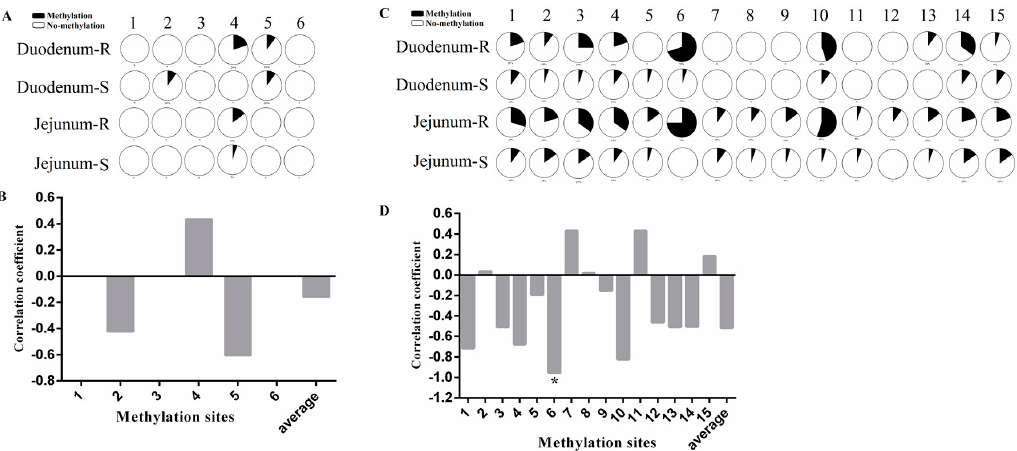
Figure 7. Methylation analysis of CpG islands in the TLR5 promoter region and correlation with mRNA expression. ( A , B ) represent methylation analysis for single site of CpG1 and its correlation analysis with mRNA expression. ( C , D ) represent methylation analysis for single site of CpG2 and its correlation analysis with mRNA expression. * indicates significant difference ( p < 0.05).